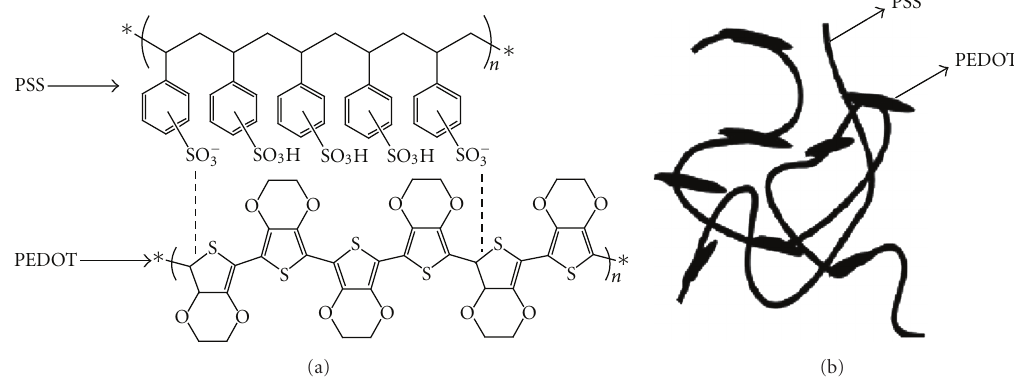
Figure 1: Molecular structure of PEDOT:PSS (a) and schematic structure of PEDOT doped PSS (b) [12].